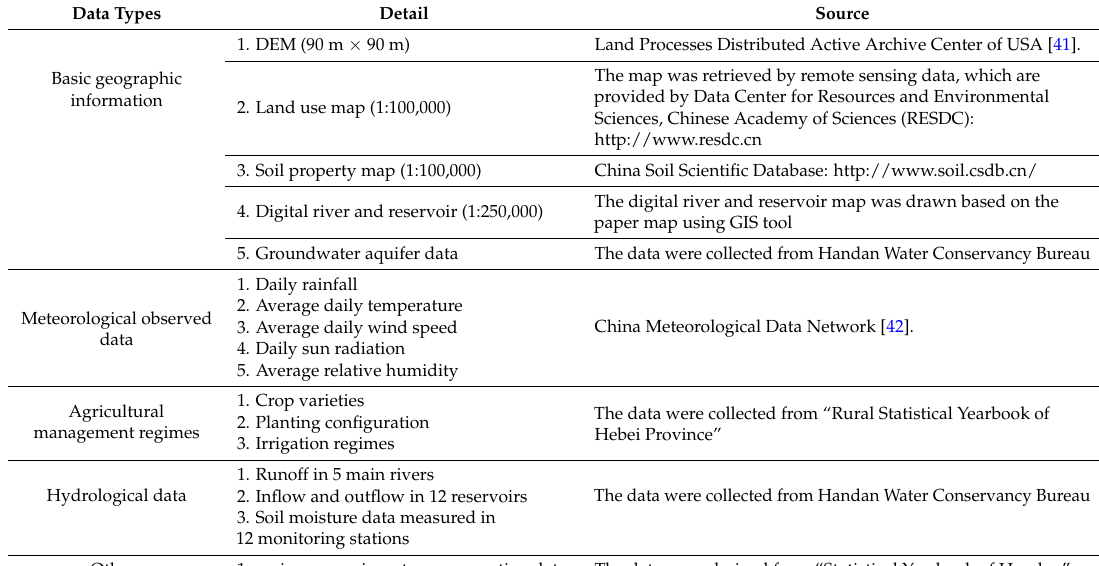
Table 3. Data required for MODCYCLE model construction.